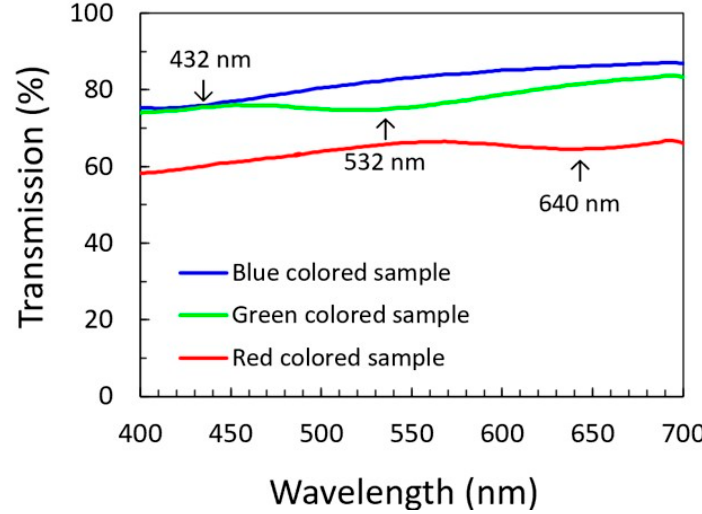
Figure 2. Transmission spectrum for visible light of various colored samples.